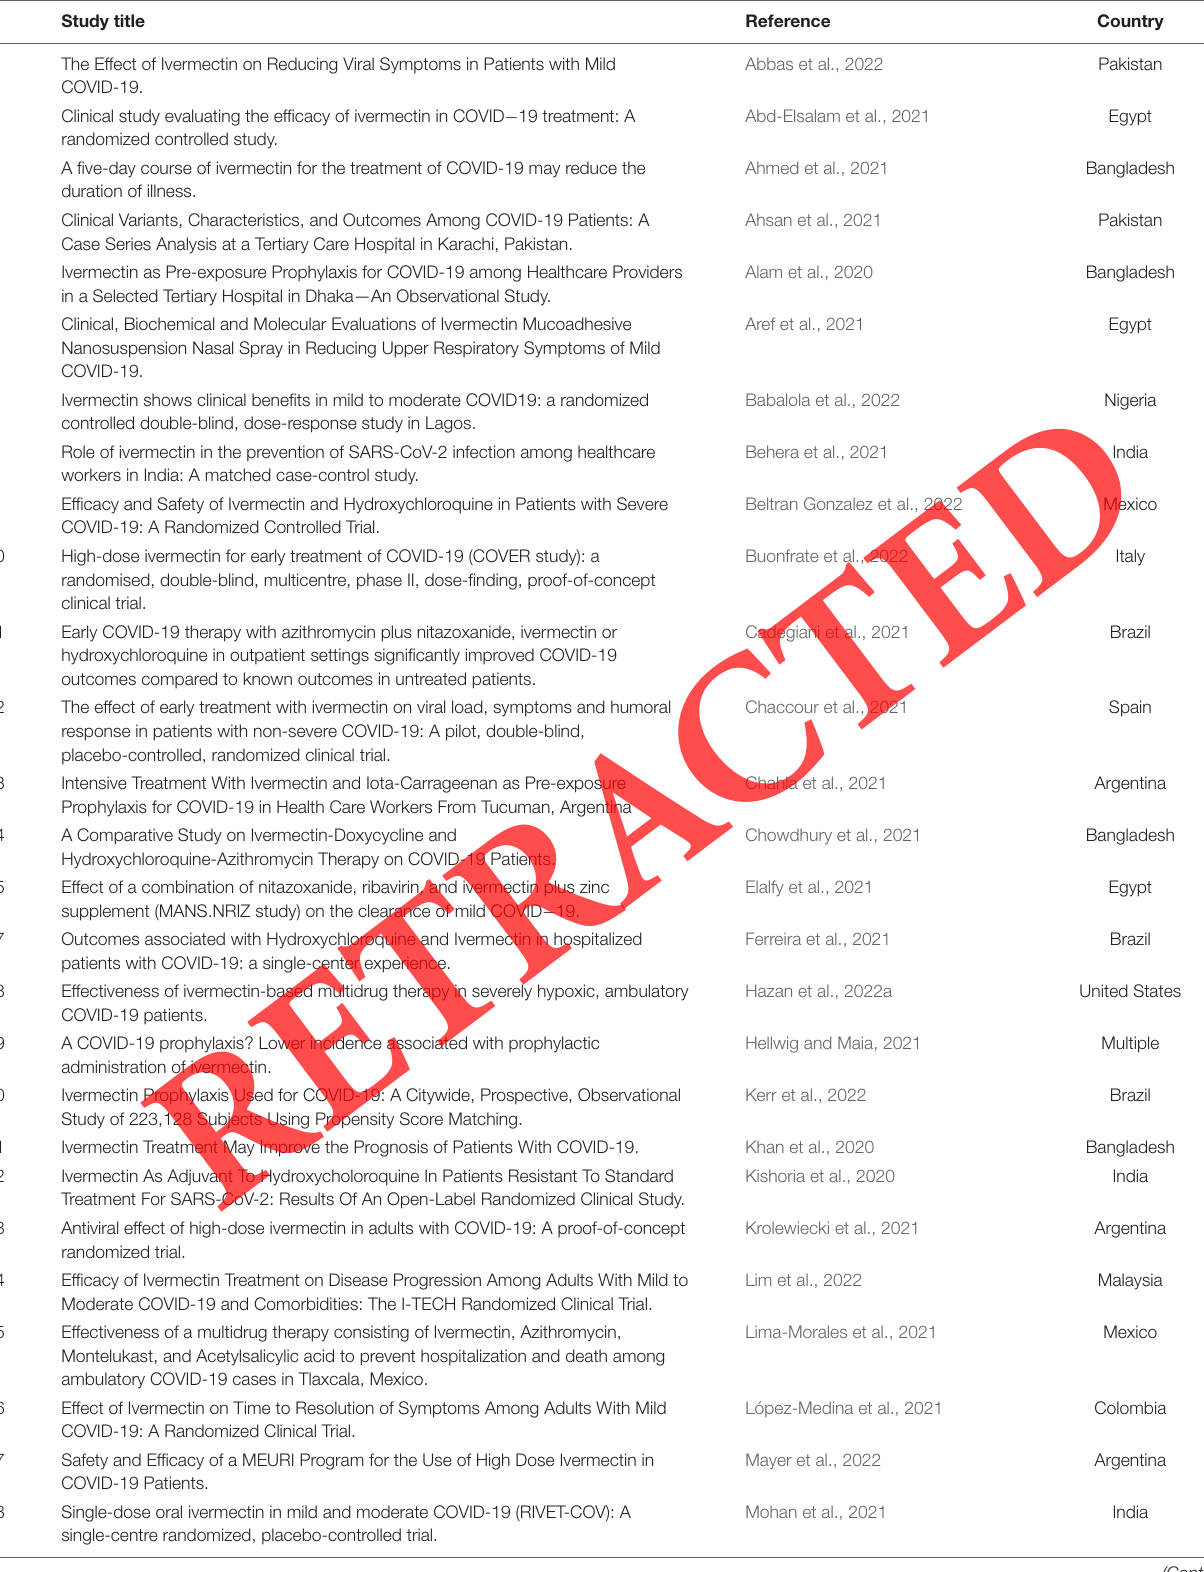
TABLE 1 | Peer-reviewed studies regarding efficacy of Ivermectin in SARS-CoV-2